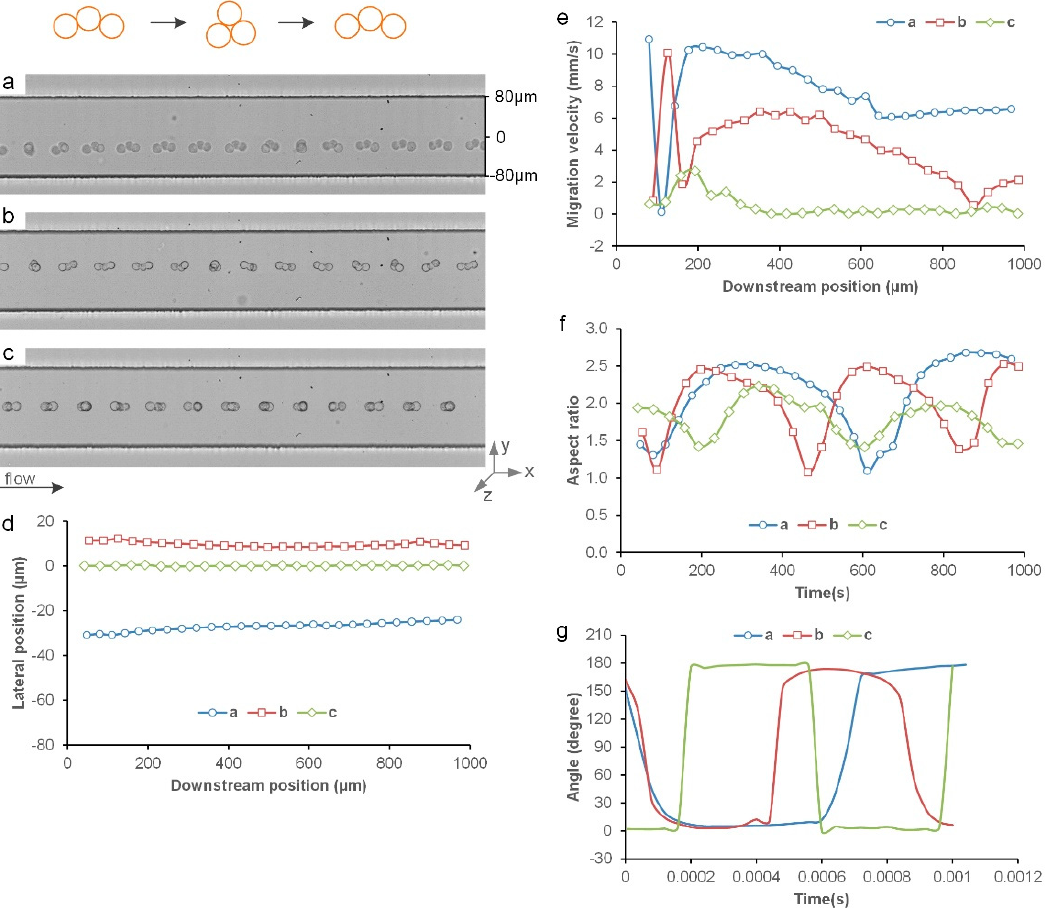
Figure 4. String triplets changing format during migration: ( a ) A string triplet fast migrates toward the centerline while rotating about y -axis; ( b ) A string triplet changes its cell arrangement while moves downstream; ( c ) A string triplet close to the channel centerline is tumbling downstream (rotating about y -axis) and changing its shape; ( d – g ) The lateral displacement, lateral migration velocity, aspect ratio, and rotation of the three doublets in ( a – c ). The bright-field images in ( a – c ) are stacked every two frames to show the trajectories of the